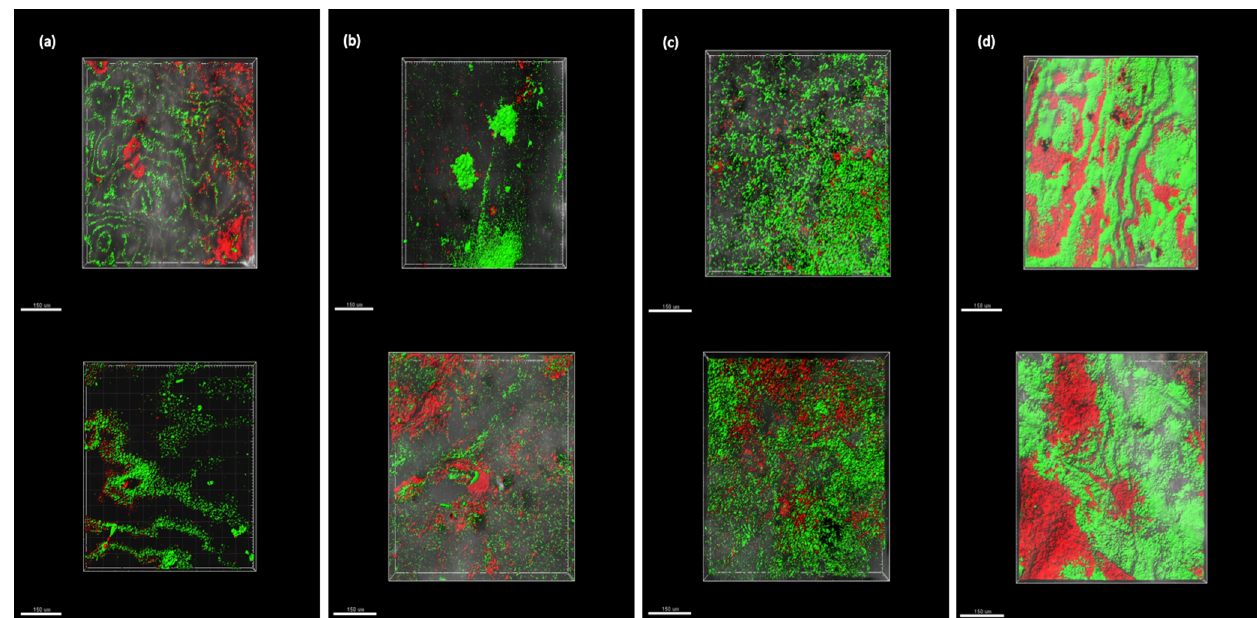
Fig. 2 Reconstructed CSLM images of live/dead-cell-stained bio fi lms on the unused control RO membranes - Biomass volume 3.15 ± 0.06 µm 3 and Bio fi lm depth 30 ± 2 µm ( a ); clean RO membranes - Biomass volume 2.72 ± 0.28 µm 3 and Bio fi lm depth 62 ± 22 µm ( b ); moderately fouled RO membranes - Biomass volume 4.04 ± 0.49 µm 3 and Bio fi lm depth 51 ± 21 µm ( c ); and severely fouled RO membranes - Biomass volume 6.16 ± 3.35 µm 3 and Bio fi lm depth 64 ± 16 µm ( d ) Table 1. Classi fi cation of membrane samples, yield of DNA and total number of OTUs per sample Sample